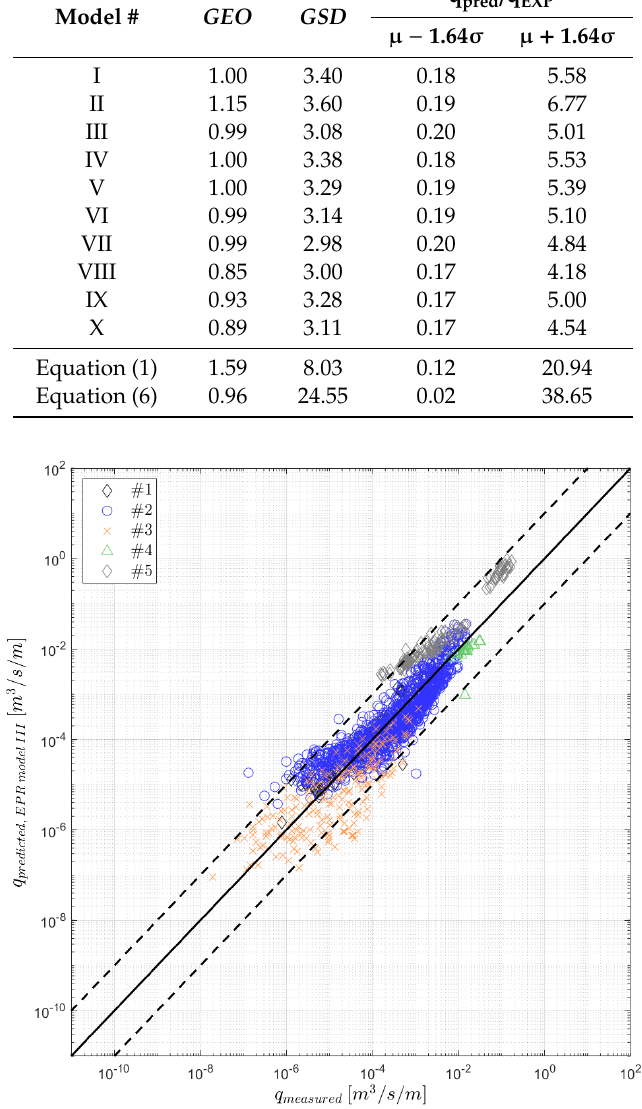
Figure 8. Comparison of overtopping prediction employing EPR model expression VII and measured overtopping discharge (solid line: prediction equal to measured rate; dashed lines: prediction equal to 10 times and 0.1 times the measured rate). 7. Discussion The set of model expressions fitted with EPR has been presented in the previous section. The exponential structure for each model expression is confirmed to be the most suited for expressing the mean overtopping discharge as widely used in the literature. The dimensionless freeboard and